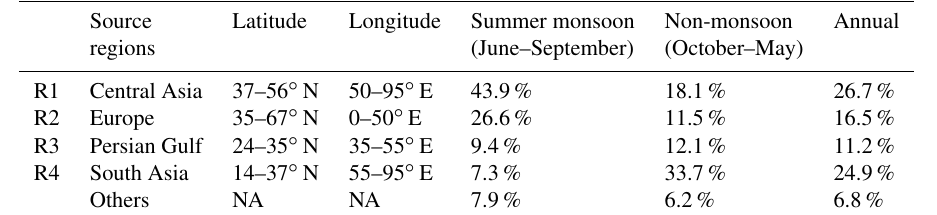
Table 1. Source regions and corresponding fractional contributions to atmospheric BC concentrations at the Muztagh Ata site in monsoon, non-monsoon and all months during 1993. NA – not available.